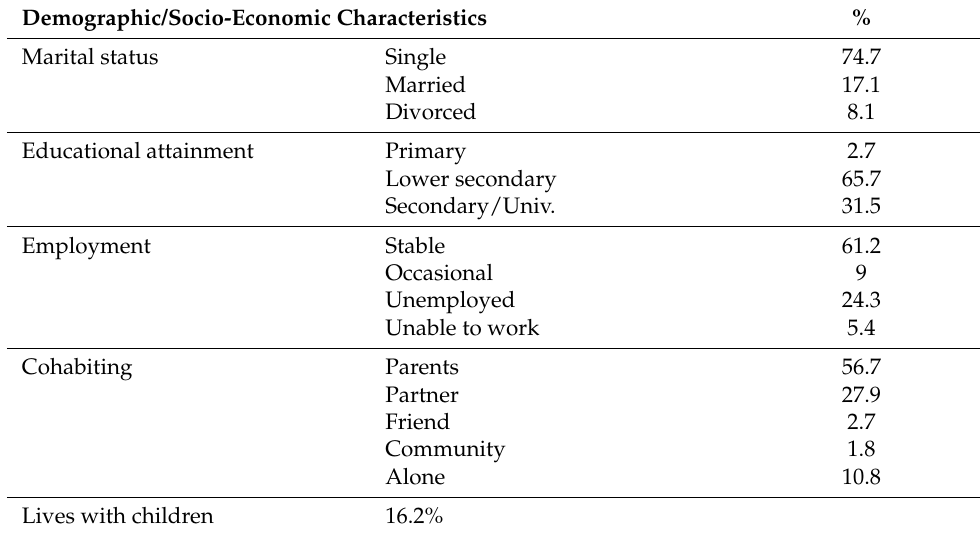
Table 1. Demographic and socio-economic characteristics of the sample, with percentages. Demographic/Socio-Economic